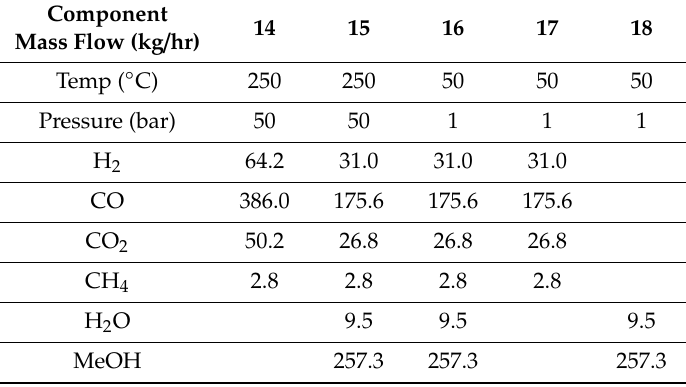
Table A4. Methanol synthesis flowsheet in Aspen